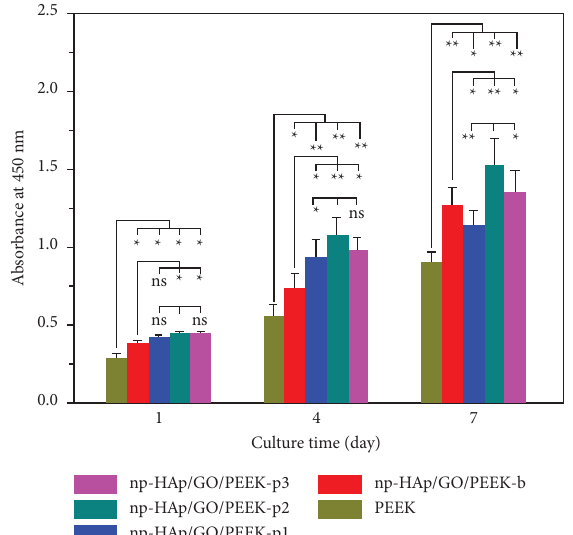
Figure 9: Cell proliferation results for MC3T3-E1 cells cultured onto the surface of PEEK nanofllers: np-HAp/GO/PEEK-b, np- HAp/GO/PEEK-p1, np-HAp/GO/PEEK-p2, and np-HAp/GO/ PEEK-p3 composites ( ∗ p < 0.05; ∗∗ p < 0.01; n � 9 in each group) (reprinted with permission from [101]) (Copyright 2021, Elsevier).